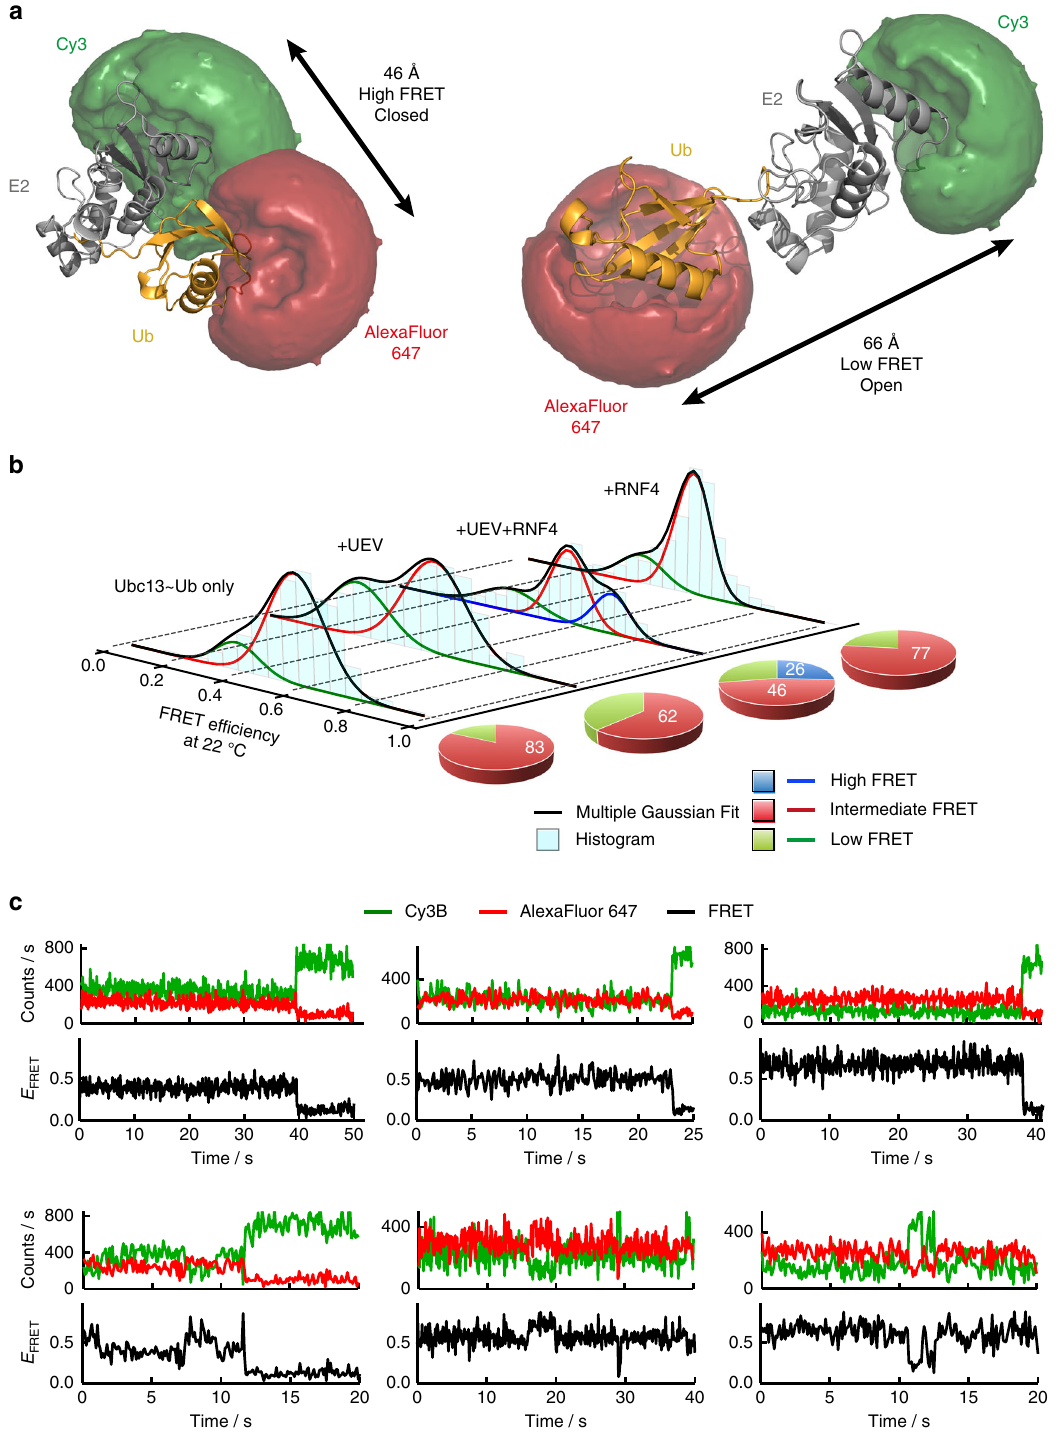
Fig. 2 UEV and RNF4 stabilise the closed conformation of Ubc13~Ub. a Modelled accessible volume of FRET dyes (Cy3 in green and AlexaFluor 647 in red) and average distance measurement for E2~Ub conjugate closed and open conformations. b smFRET histograms (cyan) showing the isopeptide linked E2~Ub conjugate conformation alone and in complex with UEV and the RNF4 RING domain dimer at 22 °C. The E2~Ub conjugate conformation in the presence of the RNF4 RING domain dimer is also shown. Gaussians are fi tted to the low FRET state (green), the intermediate FRET state (red) and the high FRET state (blue). The multiple Gaussian fi t is shown in black. The pie charts to the right of each histogram show the percentage contribution of each FRET state to the overall population, using the same colour scheme as the Gaussians fi tted to the smFRET histograms. c Representative single-molecule traces for the E2~Ub conjugate in complex with UEV and the RNF4 RING domain dimer. Each panel shows the Cy3B donor intensity (green), the AlexaFluor 647 acceptor intensity (red) and the FRET trace (black). Traces demonstrating the stability of the low, intermediate and high FRET states observed for most complexes are shown in the upper panels. Examples of traces within the 1% that show interconversion between FRET states are shown in the lower panels. Source data are provided as a Source Data fi